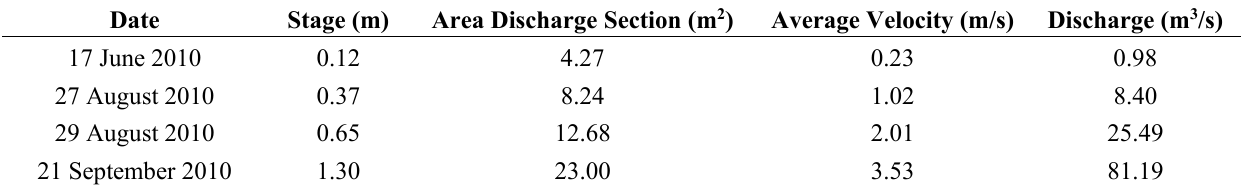
Table 2. Observed flow and channel data of the watershed case